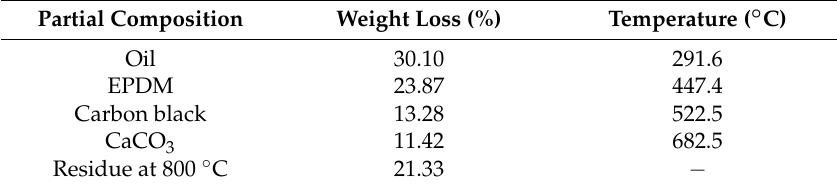
Table 2. Partial composition of the EPDM-r determined by TGA analysis.